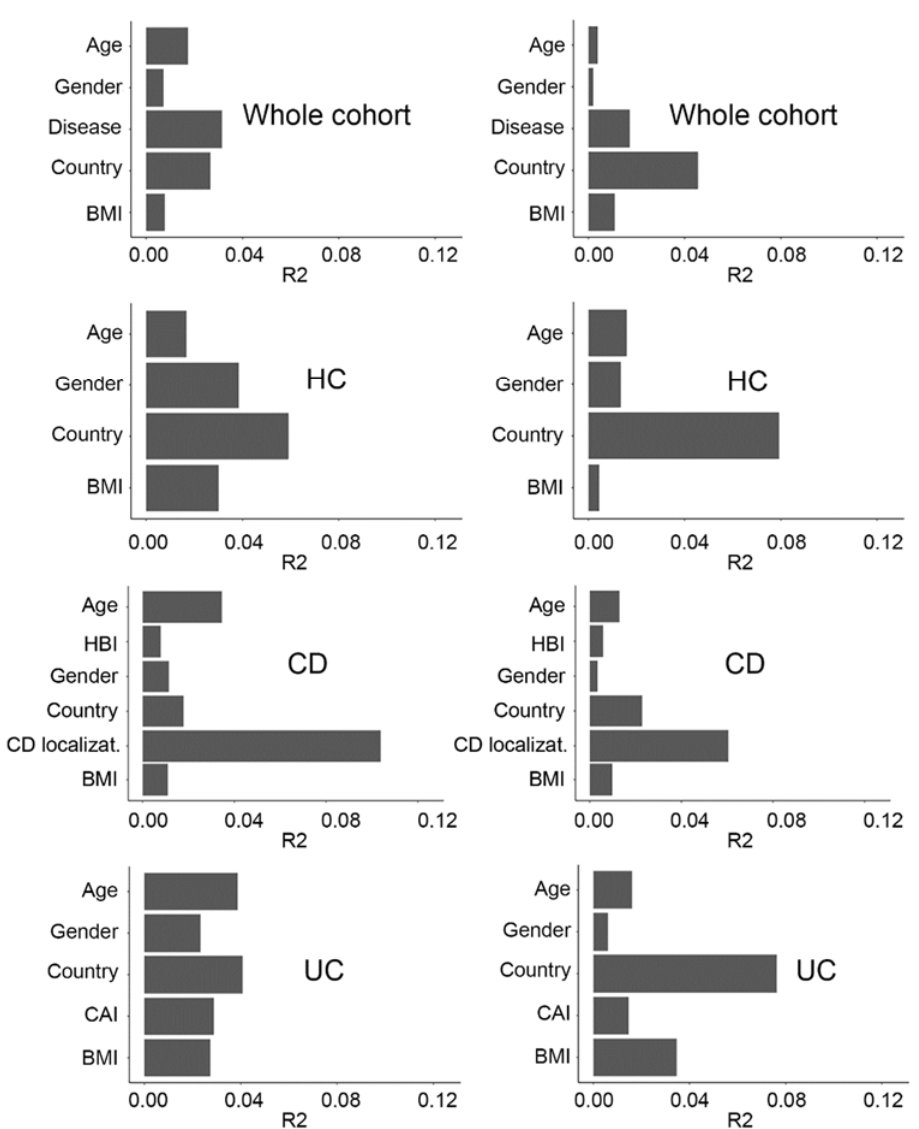
Figure 1. Covariates explaining fecal microbiome variance (PERMANOVA with unweighted (left plot)/weighted (right plot) UniFrac distances, 999 permutations). All covariates have a significant impact on microbiome variation (q < 0.05), except for BMI in HC (weighted UniFrac), gender in CD and UC (weighted UniFrac). Whole cohort ( n = 1408), HC ( n = 461), UC ( n = 384), CD ( n = 563). For the HC group, available covariates included country, age, gender, and BMI; for CD, disease localization, country, age, gender, BMI, and Harvey Bradshaw index (HBI); and for UC, country, age, gender, BMI, and colitis activity index (CAI) (Table 1, Sup ‐ plementary Table S1). For HC and UC, country appeared to be the most significant ex ‐